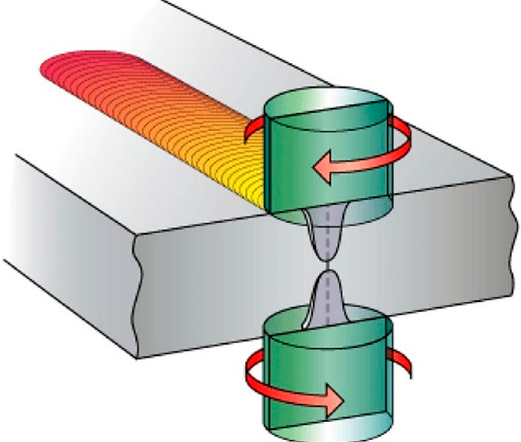
Figure 26. Welding tool arrangement in double-sided friction stir welding [199]. Reprinted from: Friction stir welded structural materials: beyond Al-alloys. International Materials Reviews 56, no. 1 (2011): 1–48, Çam, G., Copyright 2013, with permission from Taylor &